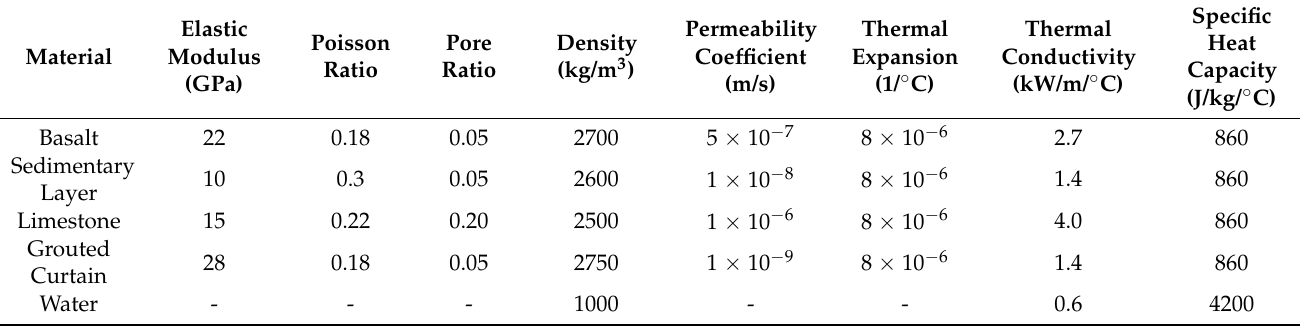
Figure 7. The impoundment process of Xiluodu reservoir. Table 2. Material parameters of bedrock and water.